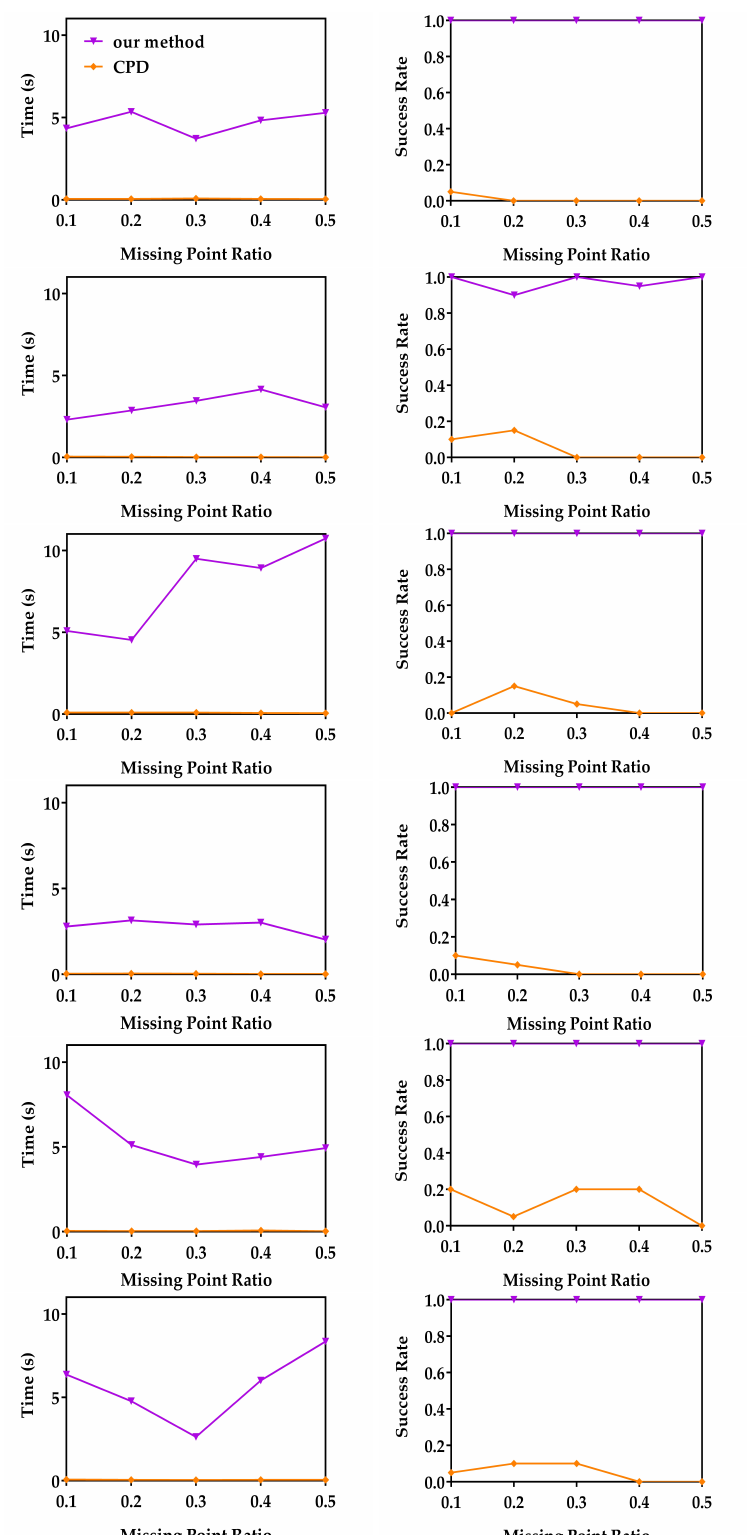
Figure 4. Median runtime and success rate with respective to the missing point ratio. Random data (first row), Archer (2nd row), Chef (3rd row), Kids (4th row), Lucy (5th row) and Owl (last row). Left column: The median runtimes of our method and CPD with respect to the missing point ratio. Right column: The mean success rates of the our method and CPD with respect to the missing point